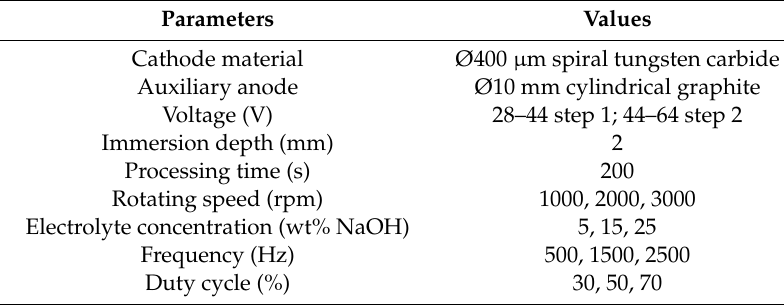
Table 2. Experimental parameters.